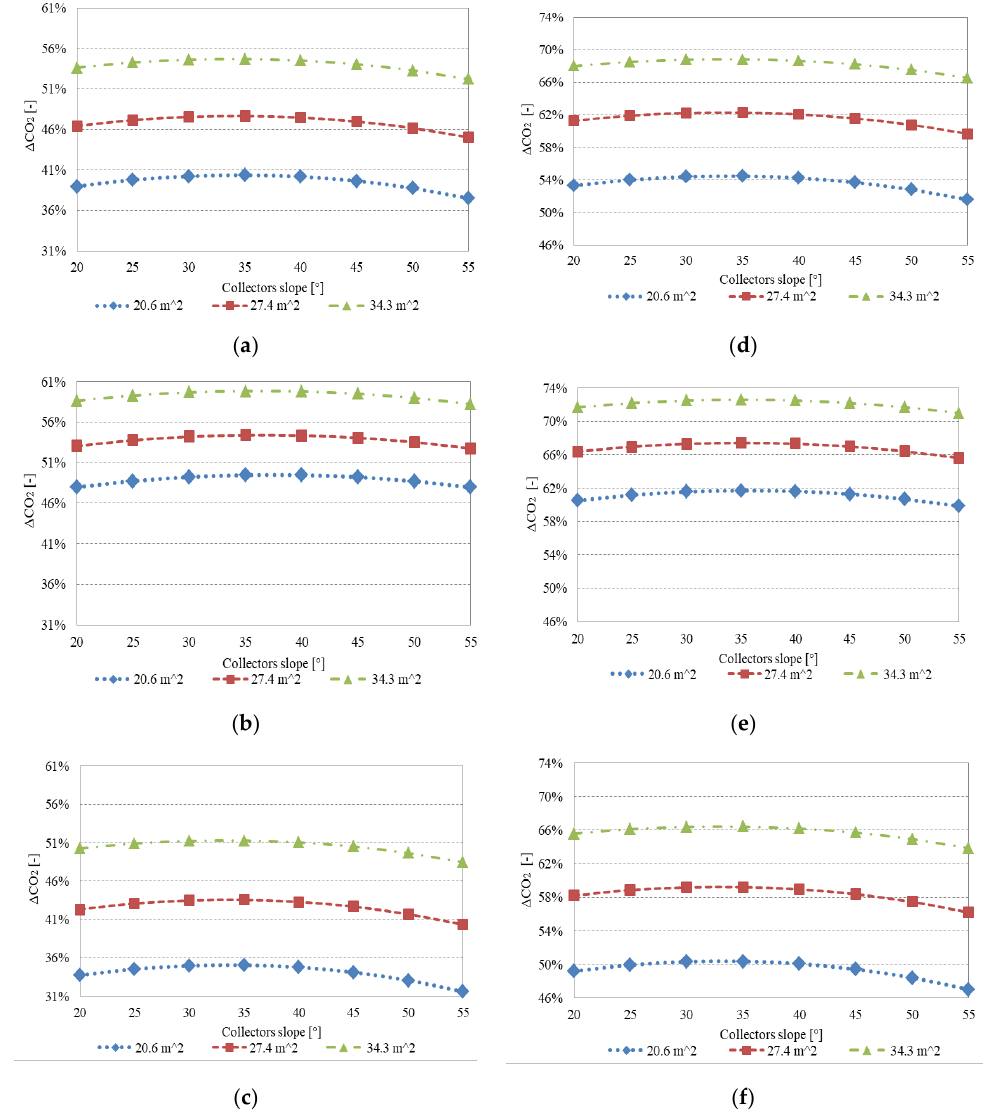
Figure 9. Equivalent avoided CO 2 emissions as a function of the tilt angle and the solar field aperture area when half of the solar thermal energy surplus is used (left side) and when it is totally used (right side) for: ( a , d ) silica-gel DW, ( b , e ) MILGO DW and ( c , f ) zeolite-rich tuff DW.